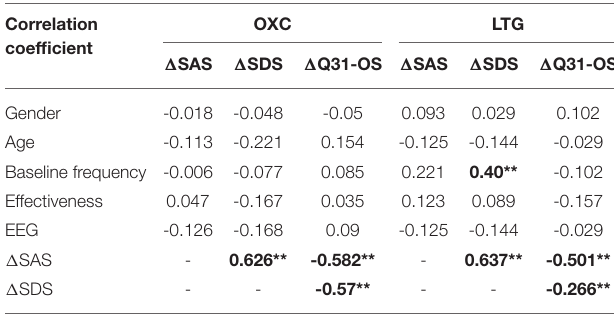
LTG, lamotrigine; 1 , scores change at 6-month follow-up compared with baseline; SAS, self-rating anxiety scale; SDS, self-rating depression scale; OS, overall score; Q31, QOLIE-31. Bold Value indicates the p < 0.05.